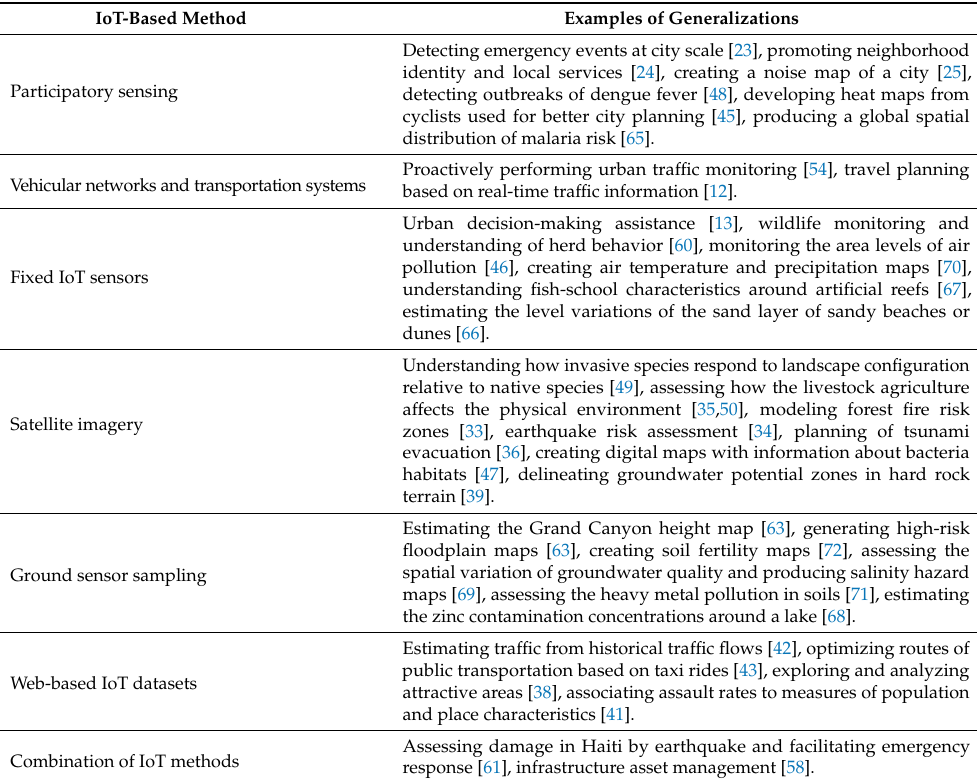
Table 2. IoT-based methods for generalization of